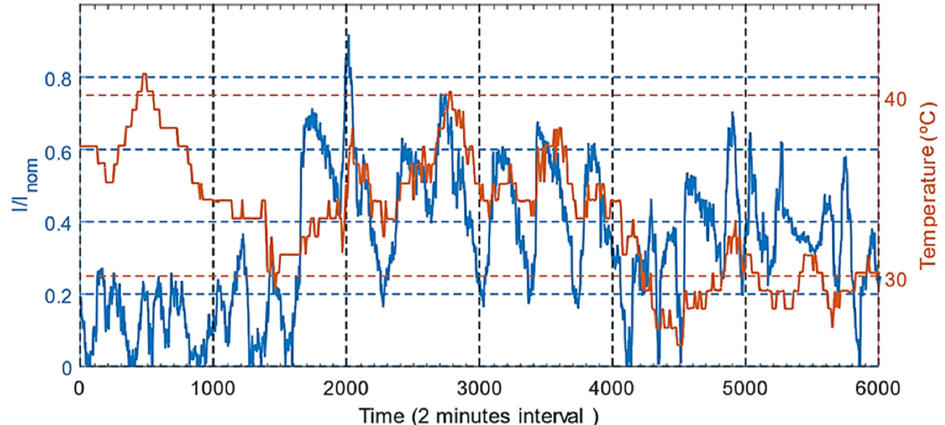
Figure 28. Evolution of load factor (blue) and temperature (orange). Despite a small delay, temper- atures align with the load variations, becoming representative of the temperature of a location in the transformer.